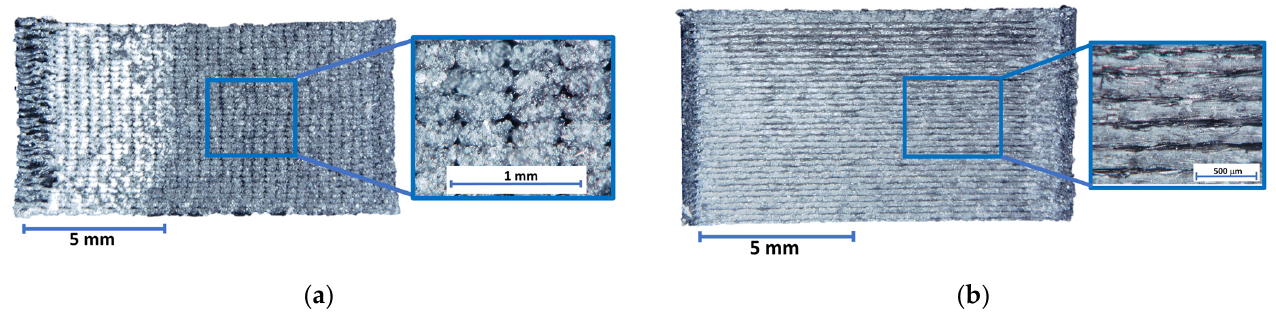
Figure 10. ( a ) Fracture surface of annealed chopped FRP-0°; ( b ) fracture surface of annealed chopped FRP-90°.